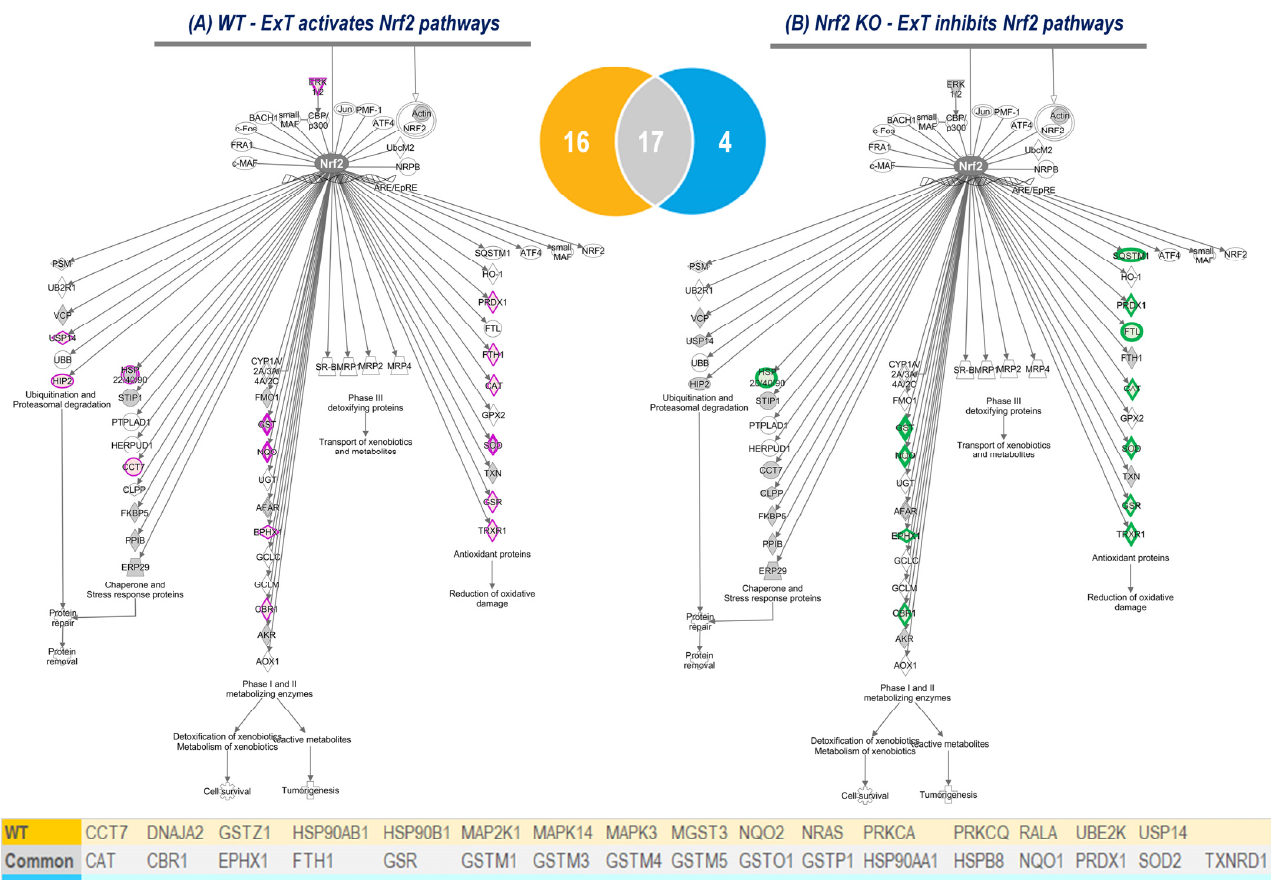
Figure 6. Nrf2 downstream proteins upregulated in WT mice (Purple symbols in ( A )) and down- regulated in Nrf2-KO mice (Green symbols in ( B )) after ExT. The Venn diagram shows overlap of Nrf2-associated proteins identified in WT and Nrf2-KO mice. Their gene IDs are listed in the inserted table with yellow as WT unique, grey as the common, and blue as Nrf2-KO unique.